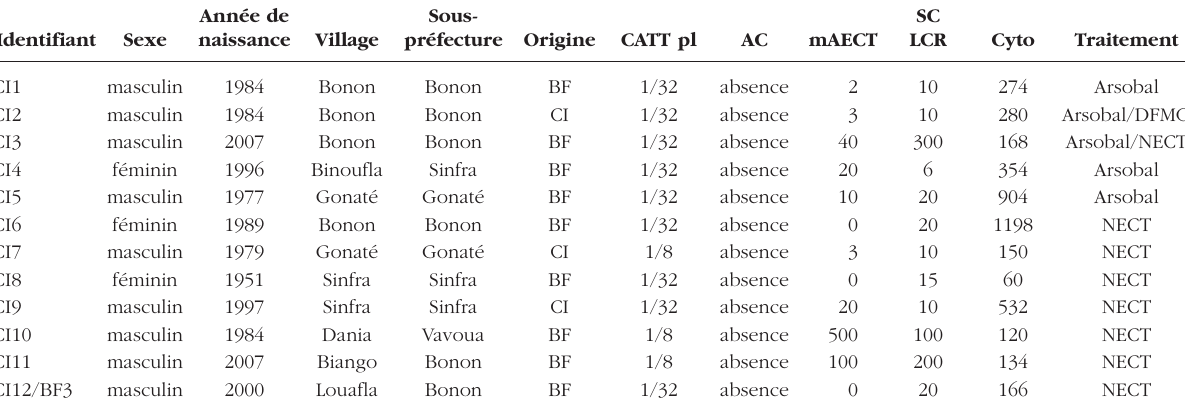
Tableau III. – Description des 12 trypanosomés dépistés passivement en Côte